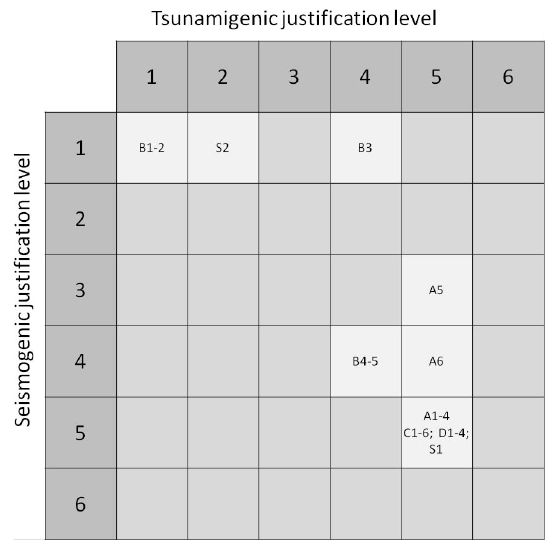
Fig. 4. Matrix for classifying the combined justification levels for the existence of fault sources in terms of both seismogenic and tsunamigenic evidences (data for this classification reported in Table